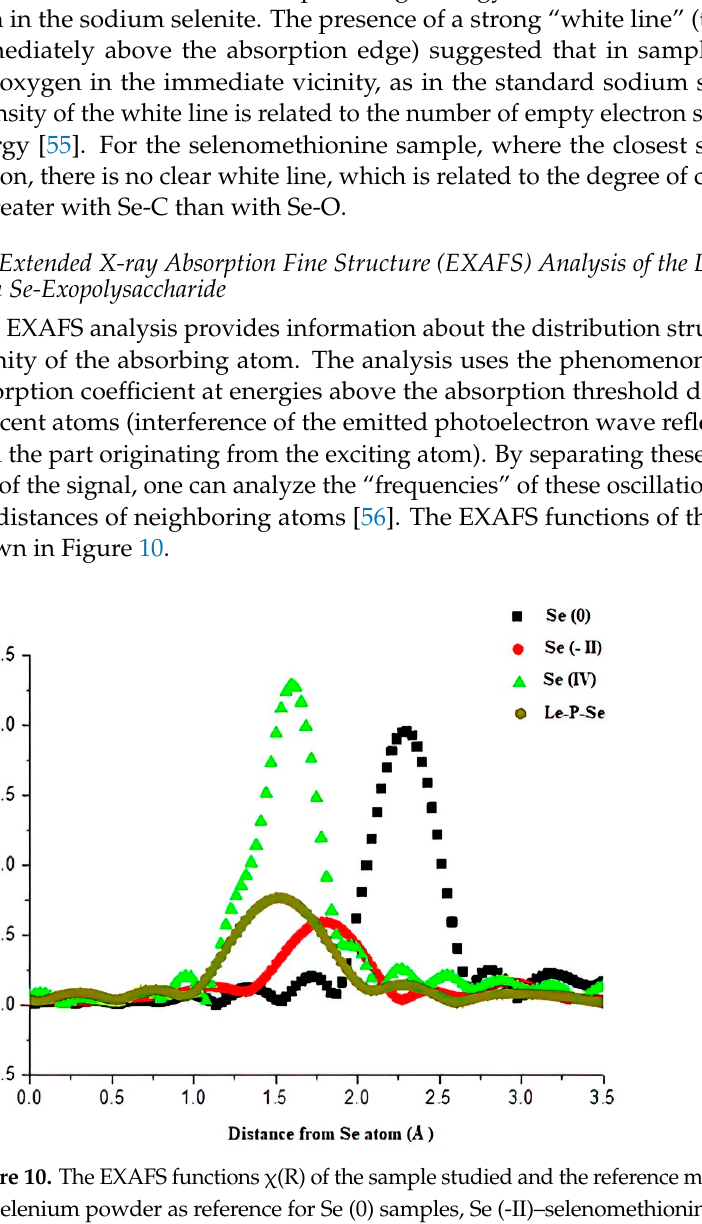
exopolysaccharide